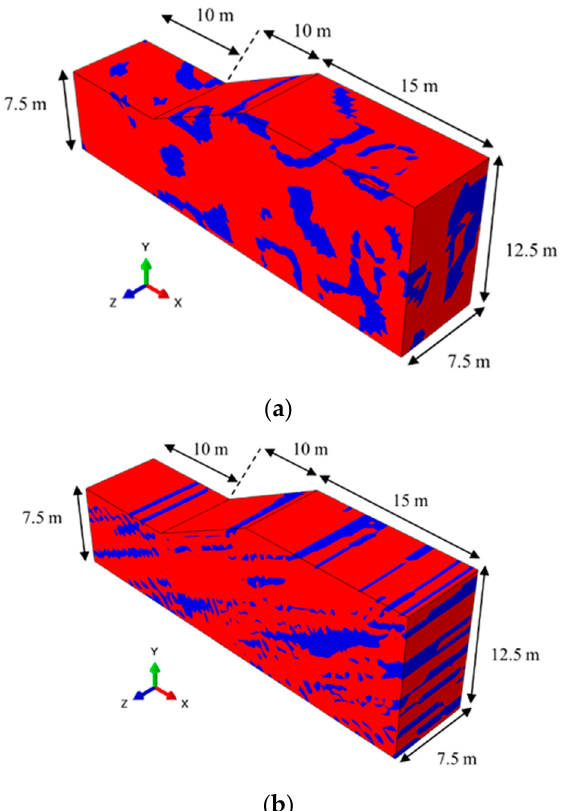
Figure 2. Schematic diagram of the distribution of weak zones (red represents rocks, blue represents weak zones). ( a ) Typical sample of slope with homogenous weak zones (correlation length along all directions is 5 m); ( b ) typical sample of slope with layered weak zones (correlation length along x directions is 20 m; correlation length along y direction is 5 m; correlation length along z direction is 1000 m).